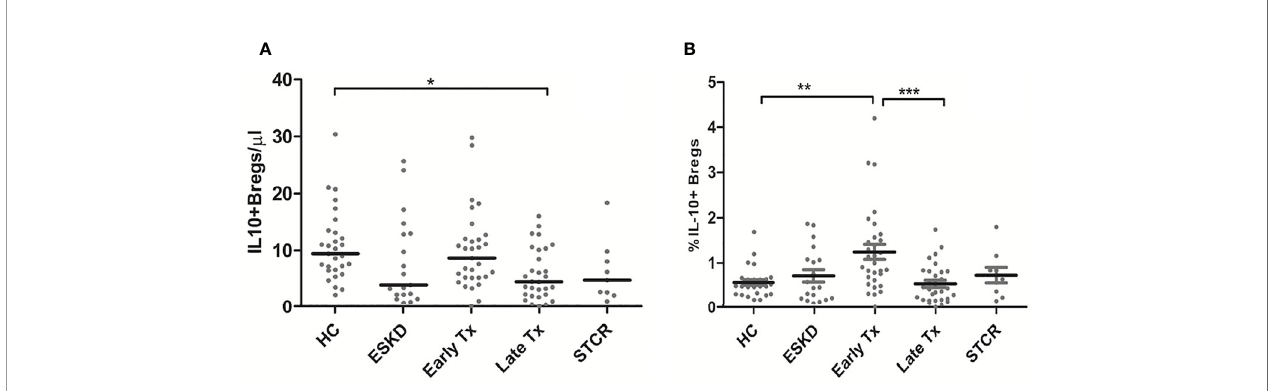
FIGURE 4 | Comparison of the absolute CD19+IL-10+ Breg counts (A) and the percentage of CD19+IL-10+ Bregs within the CD45+ lymphocytes pool (B) among healthy controls (HC), end-stage kidney disease on regular dialysis (ESKD), early and late transplant recipients (Tx), and transplant recipients with a steroid-treated acute rejection (STCR): Medians were compared among the groups with Kruskal-Wallis test and p-values were adjusted after correction for multiple comparisons, *p < 0.05, **p < 0.01, ***p <